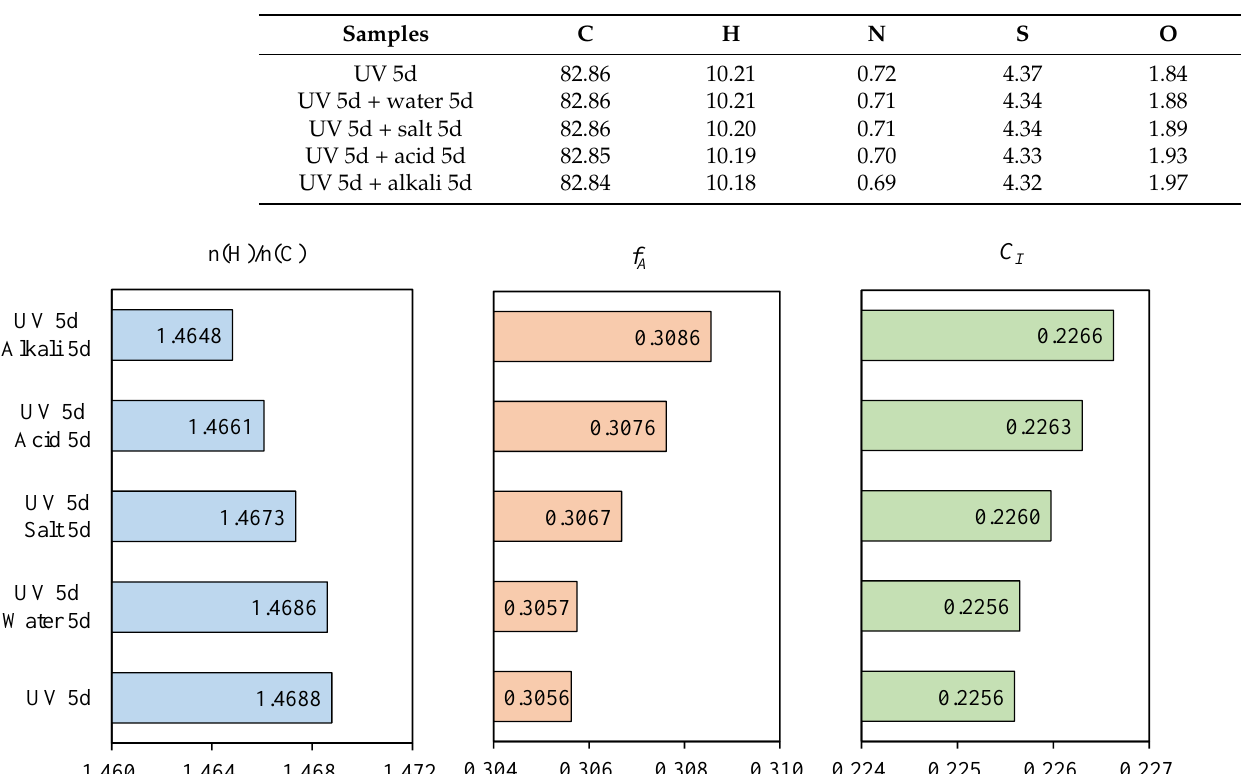
Figure 7. Important indexes (n(H)/n(C), f A and C I ) of asphalt after the multiple aging of UV and aqueous solution.